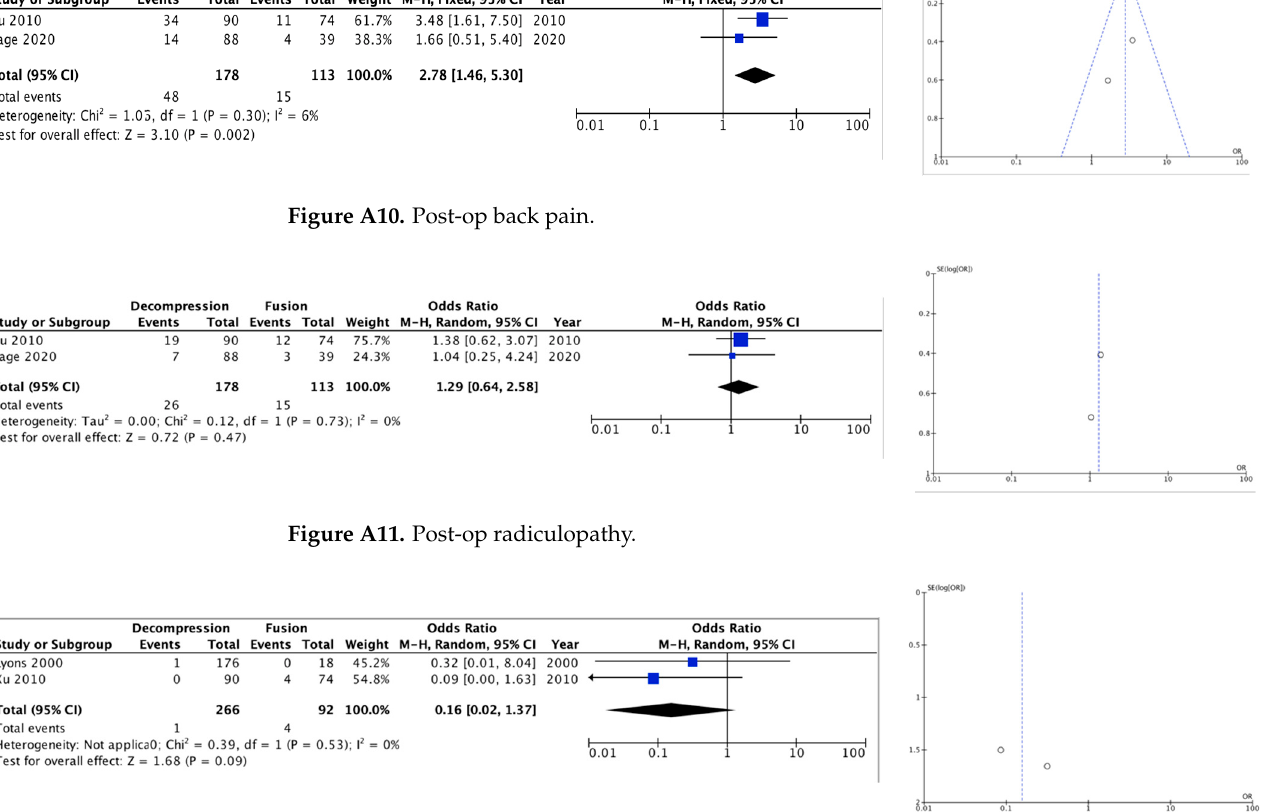
Figure A13. CSF leakage.